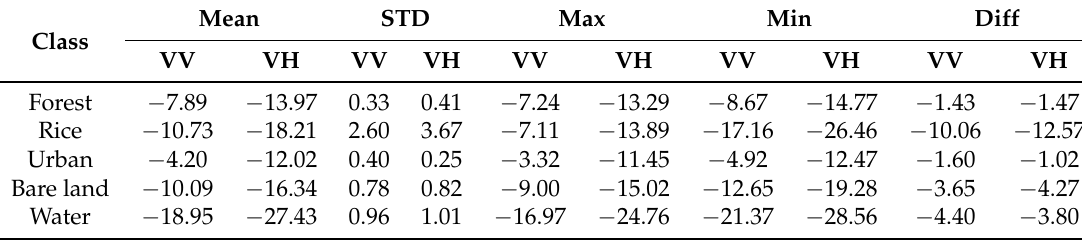
Figure 5. The average backscatter of 5 land-cover classes in the RRD. The VH-, and VV-average backscatter coefficient are respectively shown in ( a , b ). Table 3. Statistical measures of VV and VH channels for different land